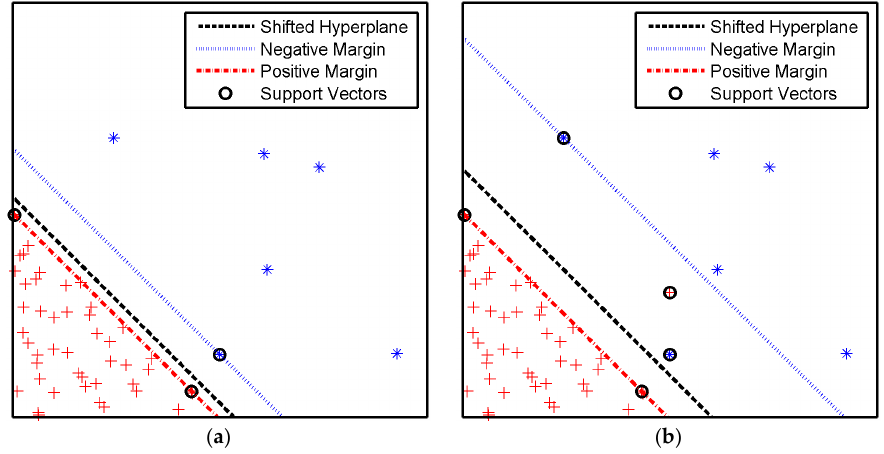
Figure 2. Hyperplane shifted with data points: ( a ) two classes are linearly separable; and ( b ) two classes are not linearly separable.